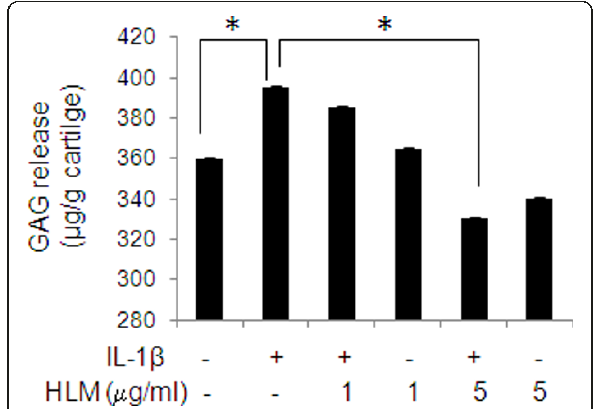
Figure 5 Cartilage matrix status . HLM inhibited the IL-1 b -induced release of GAG from human cartilage explants in vitro . Cartilage pieces (26.7 mg ± 1.3) were incubated with medium alone or medium containing either IL-1 b alone or in combination with HLM (1 and 5 μ g/ml) for 7 days. Total GAG release from cartilage explants in culture supernatants was quantified by using Proteoglycan detection kit and values are derived from standard curve. Value represents Mean ± SD of three different experiments repeated in duplicate. * p <